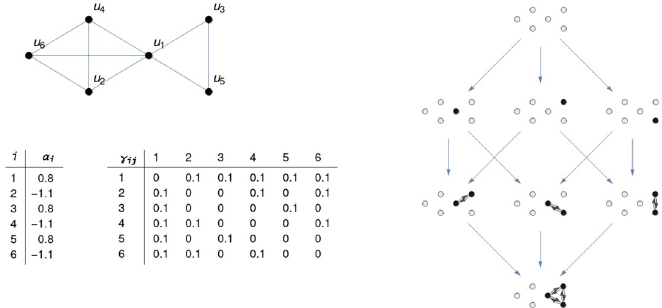
Fig 1. Information structure. Graph with six nodes (top left) where a dynamics is defined by means of a Lotka- Volterra cooperative system with α and γ parameters as shown in the tables below. The attractor associated to the i ij system, the information structure (IS) is shown on the right. Its eight nodes correspond to non-negative stationary points in the dynamics of the system. These stationary points are characterised by the value of each node in the system. The nodes u i shown in white indicate that u i = 0 at the corresponding point of the IS. Black nodes indicate that u i > 0. Links between nodes u and u are those in the system (top left) where both u , u > 0. The blue arrows linking different i j i j points of the IS represent transitions going from one stationary solution (limit with time approaching − 1 ) to another (when time approaches + 1 ). For clarity, transitive arrows are not